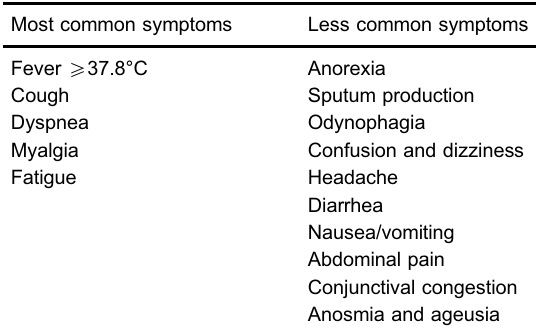
Table 2. Most described symptoms in